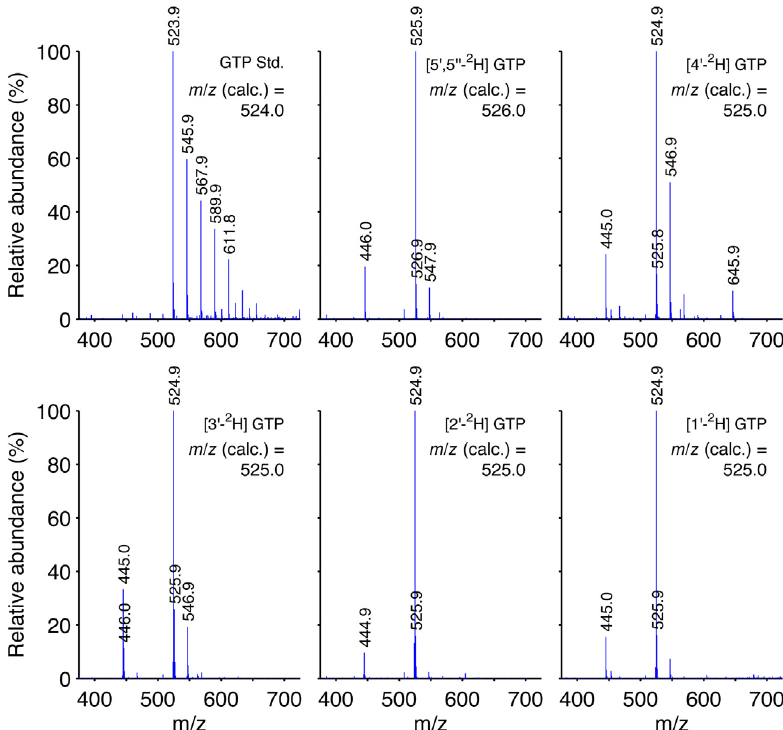
Figure 15. Mass spectra of a GTP disodium standard (A) and deuterated GTP analogs (B – F). Calculated m / z values shown in the top right of each panel correspond to the [M+H] + molecular ion of